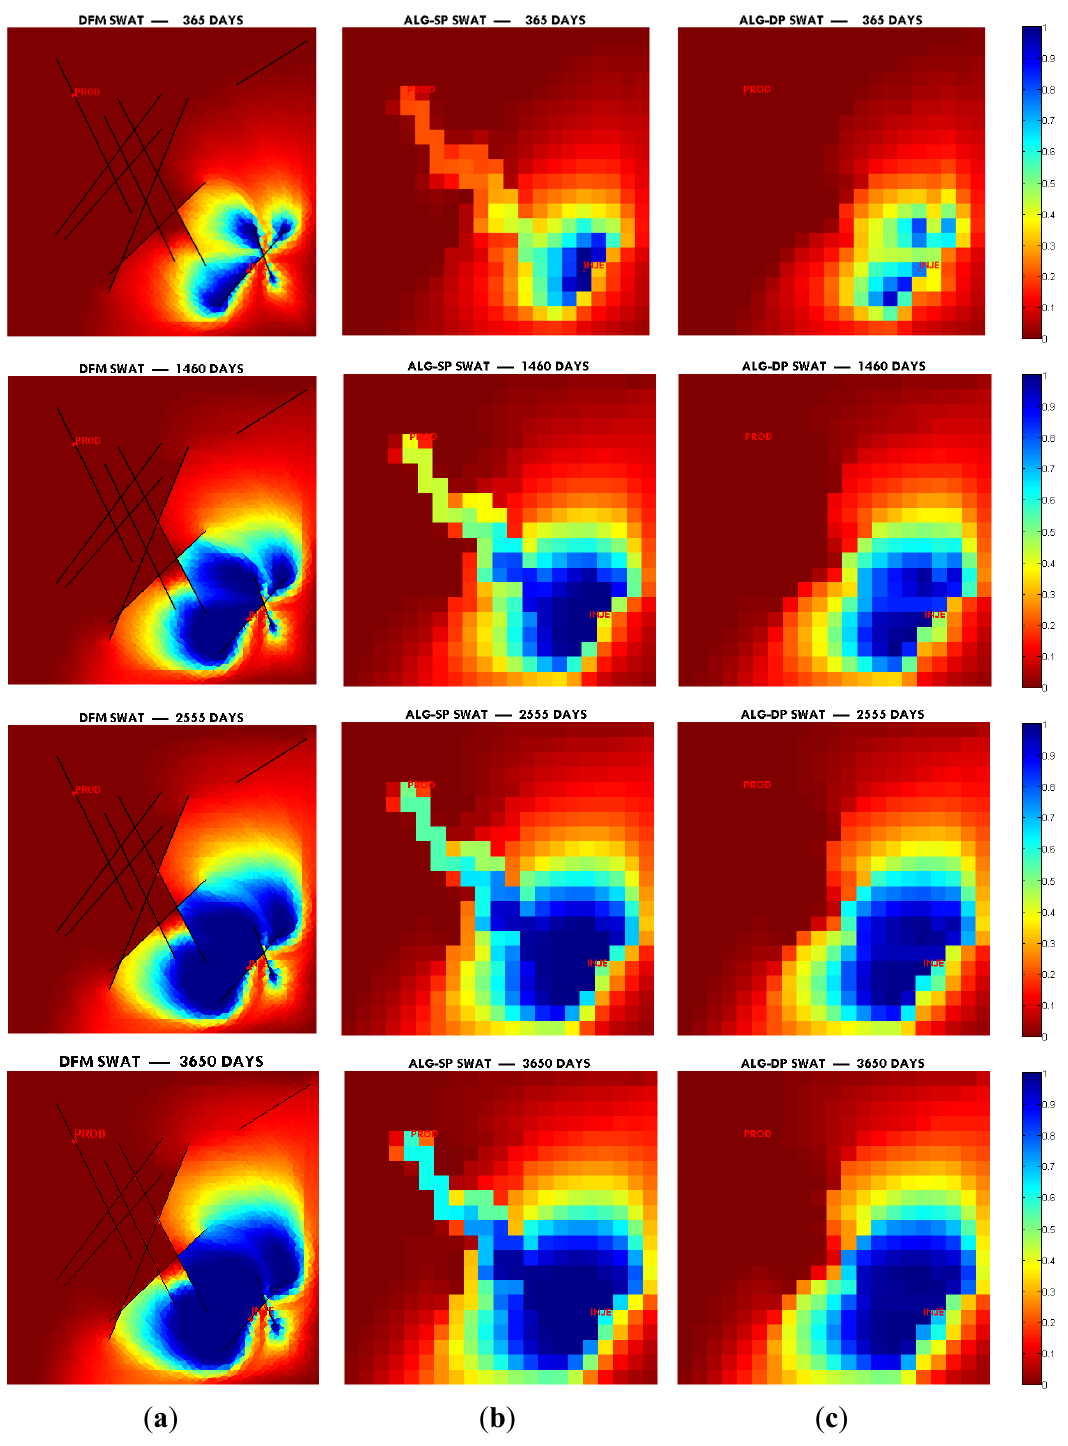
Figure 6. Water saturation fields for case 1 at 365/1460/2555/3650 days. ( a ) DFM fine model; ( b ) ALG-SP coarse model; ( c ) ALG-DP coarse